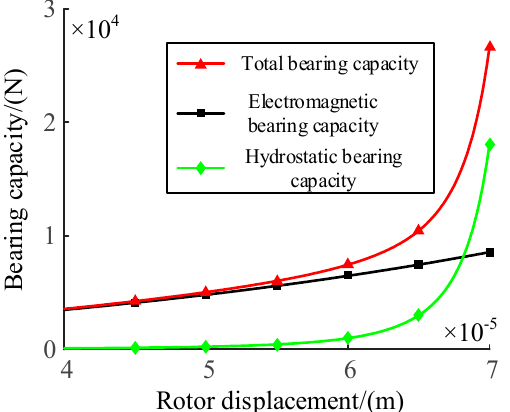
Figure 4. Relation curve between bearing capacity and displacement ∆ x .